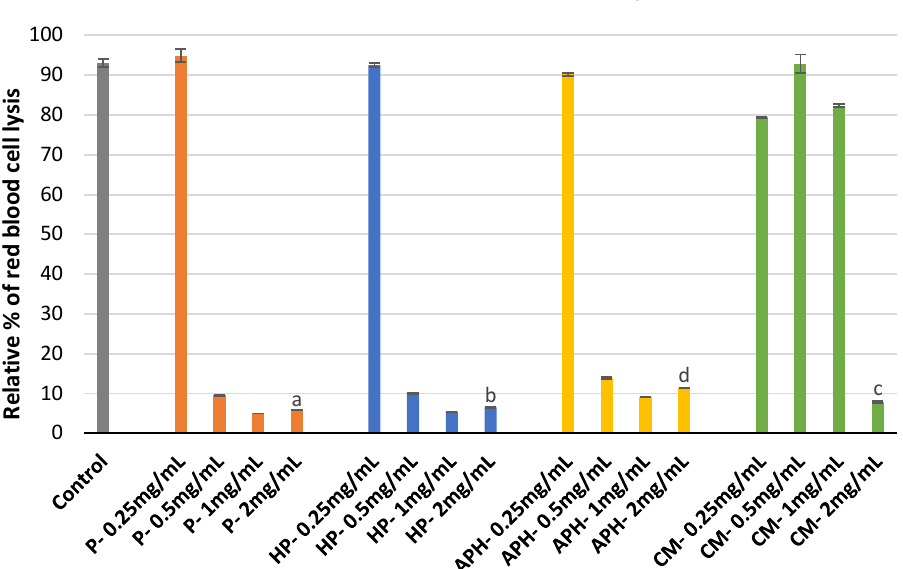
Figure 2. Modulation of AAPH -induced red blood cell lysis by P (water-soluble extract of pasteurized minced meat of BSFL), HP (water-soluble extract of hydrolyzed and pasteurized minced meat of BSFL), APH (hydrolysate of water-soluble BSFL proteins), and CM (water-soluble extract of chicken meal). Results expressed as mean ± standard deviation (n = 3). Differences in the letters above the bars (a, b, c, and d) represent significant differences ( p < 0.05) in prevention of AAPH-induced red blood cell lysis by different samples analyzed during this assay.